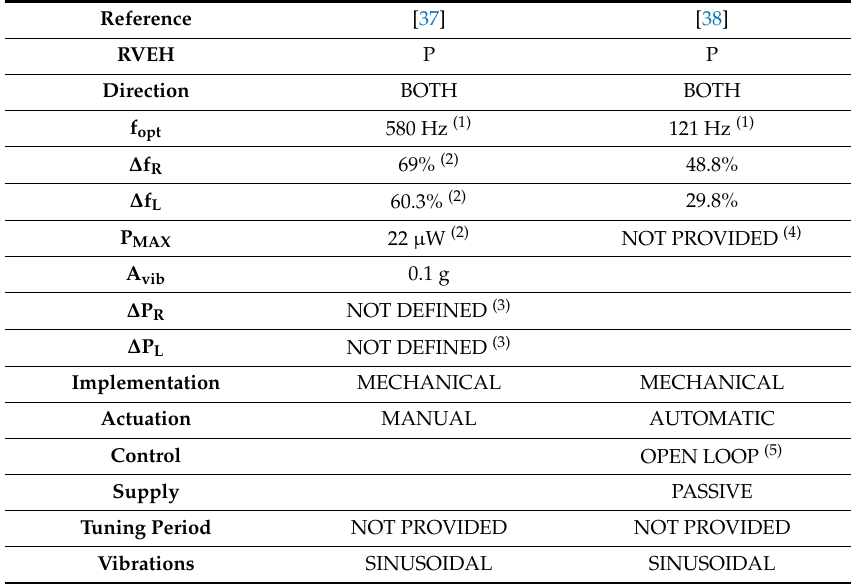
Figure 20. Schematic representation of the clamp position change based MTT proposed in [38]. A summary of the described clamp position change based MTTs is reported in Table 5. Table 5. Clamp position change based MTTs classification indicators.